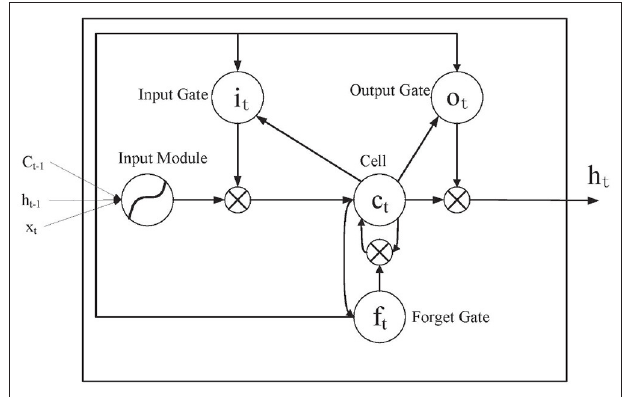
FIGURE 4 | Long short-term memory internal structure